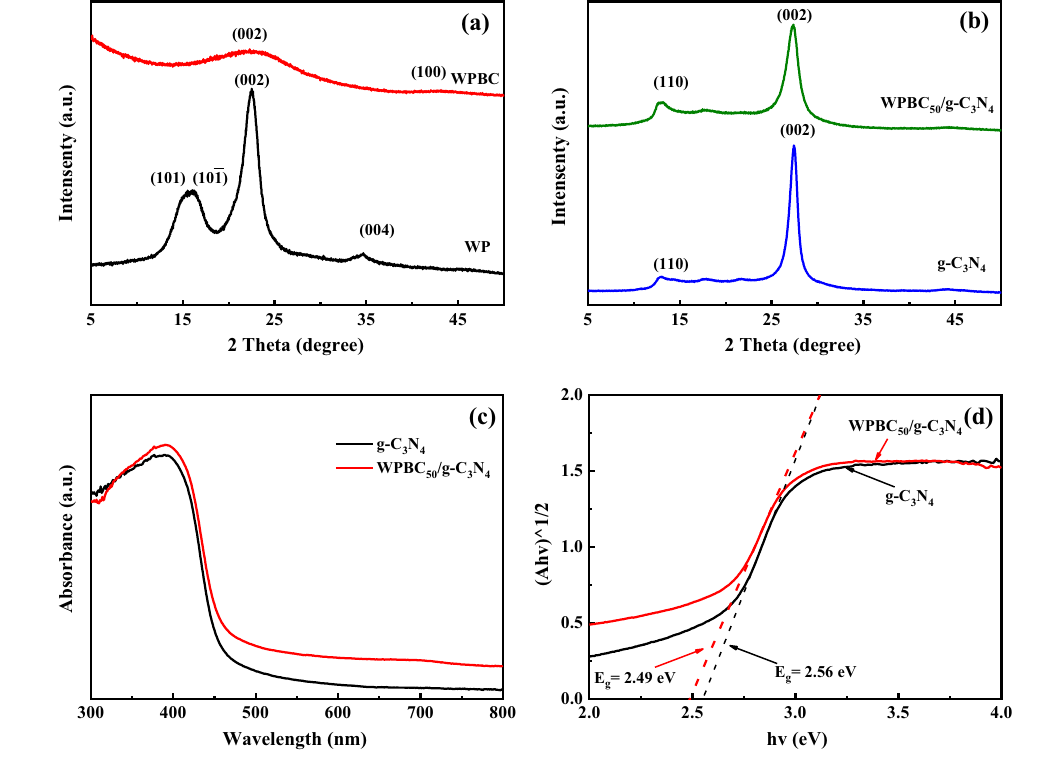
Fig. 2 XRD patterns of a WP and WPBC, b g-C 3 N 4 and WPBC 50 /g-C 3 N 4 , c the UV–visible diffuse reflectance absorption spectra and d energy band gaps of